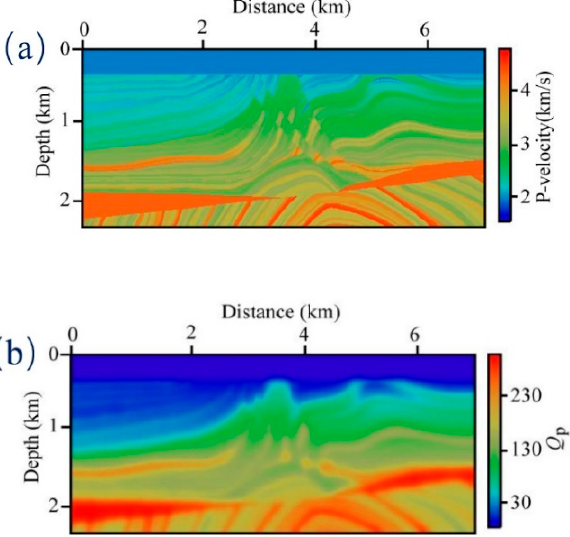
Figure 6. The Marmousi ( a ) P − wave velocity and ( b ) quality factor Q p